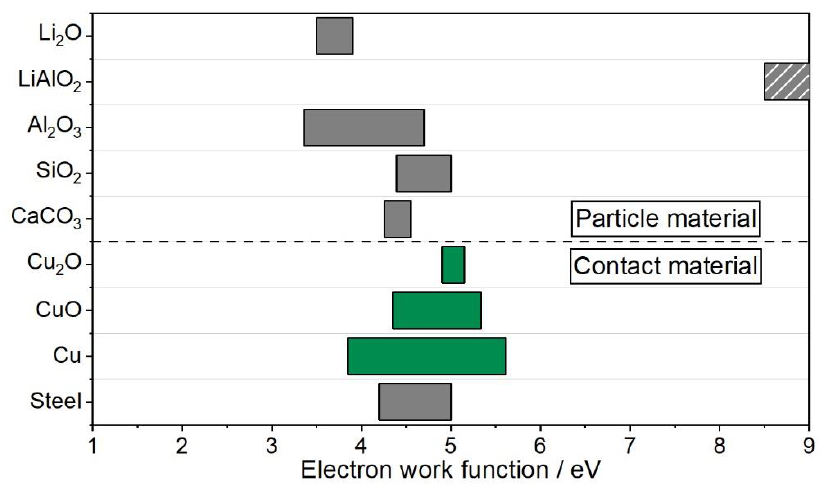
Figure 1. Overview over the different work functions of the used materials: Cu [30], stainless steel [31,32], Al 2 O 3 [30,33], CaCO 3 [12,23], SiO 2 [12,30], LiAlO 2 (cf. Appendix A), and Li 2 O [34,35] (copper-containing species are indicated in green, and self-measured LiALO 2 is indicated in grey with white stripes).